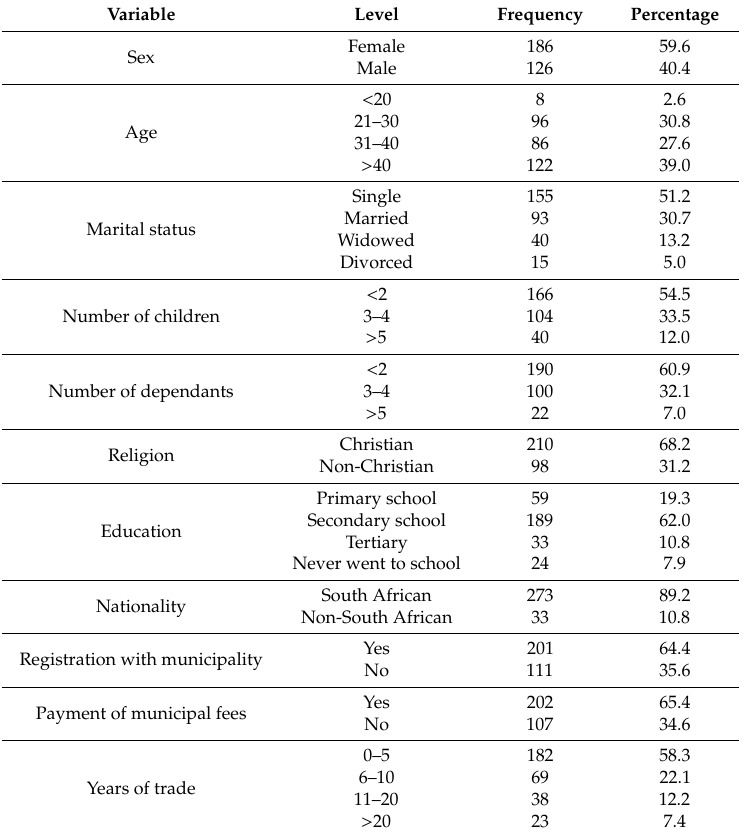
Table 1. Demographic characteristics of the street food vendors ( n =